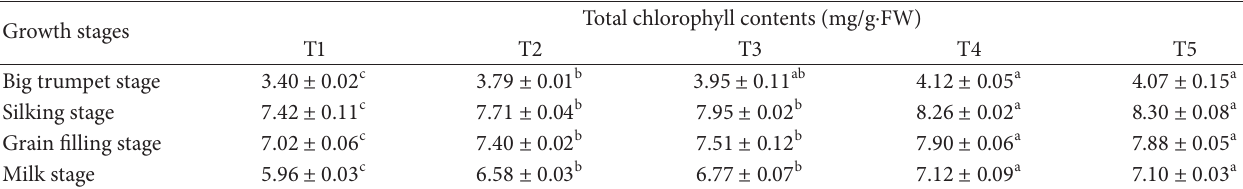
Table 2: Effects of Si application on total chlorophyll contents in leaves of